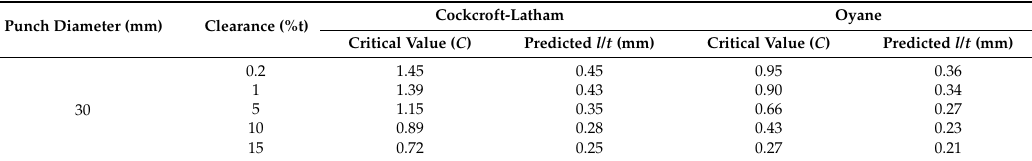
Table 5. The values of the critical ductile fracture criteria ( C ) for different clearances and sheared surface lengths predicted by the punch diameter of 30 mm for a blank thickness of 1.6 mm.